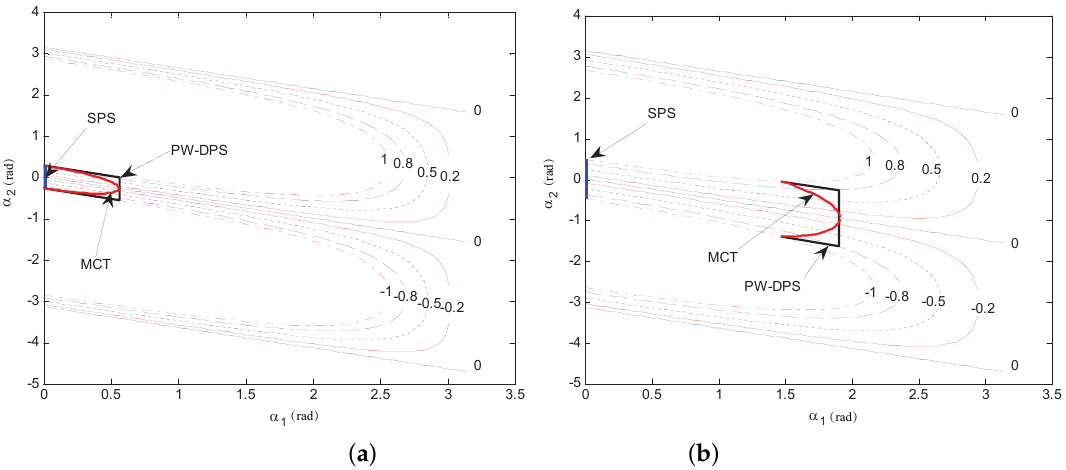
Figure 8. The normalized bidirectional power with regards to the controlled phase-shift angles under single-phase-shift (SPS), minimum current trajectory (MCT), and PW-DPS control at ( a ) M = 0.96 and ( b ) M =